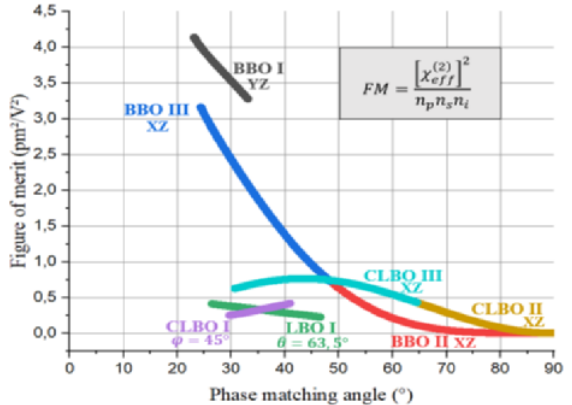
Fig. 1. Figure of merit as a function of phase-matching angles for BBO, LBO and CLBO crystals when pumped at 0.355 µm and generating between 0.4 µm and 0.9 µm from